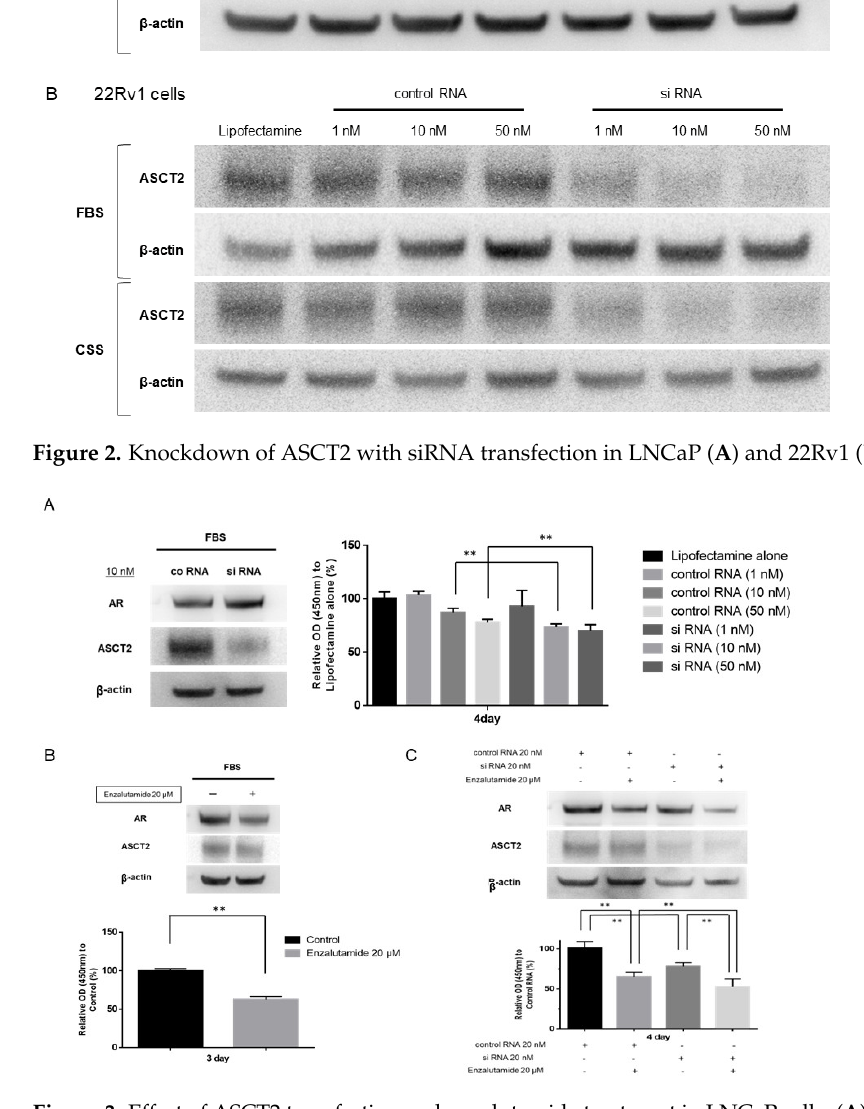
Figure 3. Effect of ASCT2 transfection and enzalutamide treatment in LNCaP cells. ( A ) Representa- tive images of Western blot analyses of LNCaP cells after transfection of ASCT2 siRNA (10 nM)